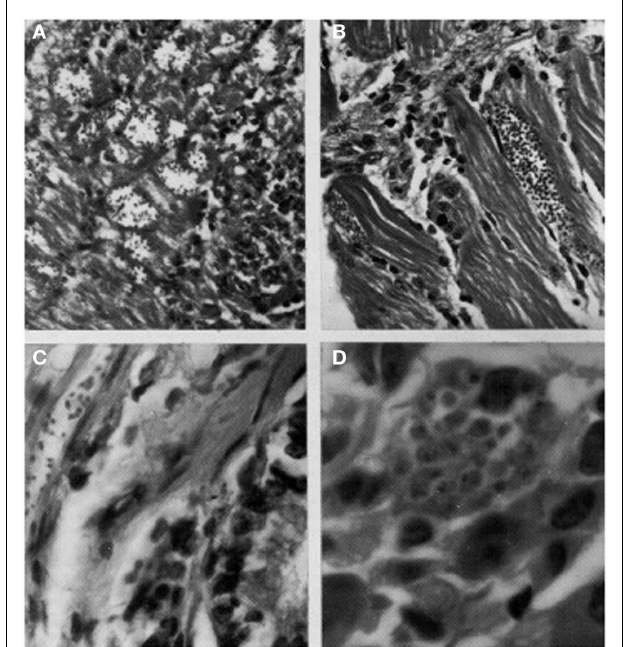
FIGURE 4 | Histological sections showing pseudocysts of Trypanosoma cruzi with amastigotes in (A) cardiac tissue of naturally infected Rattus rattus (H-E; 560 × ); (B) skeletal muscle of naturally infected R. rattus (H-E, 560 × ); (C) smooth muscle fiber from the colon of an experimentally infected mouse (H-E, 960 × ); (D) acinar cell of pancreas of experimentally infected mouse (H-E, 1400 ×